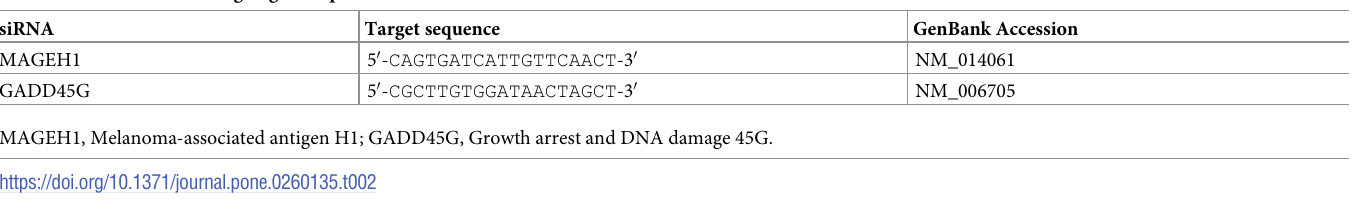
Table 2. siRNAs for silencing of gene expression in HK-2